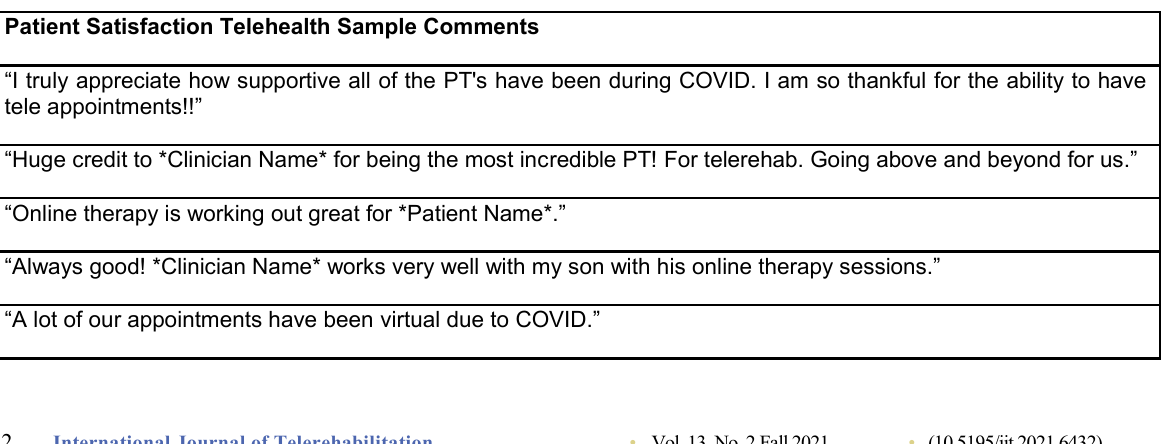
Rehabilitation Services Telehealth Satisfaction Survey